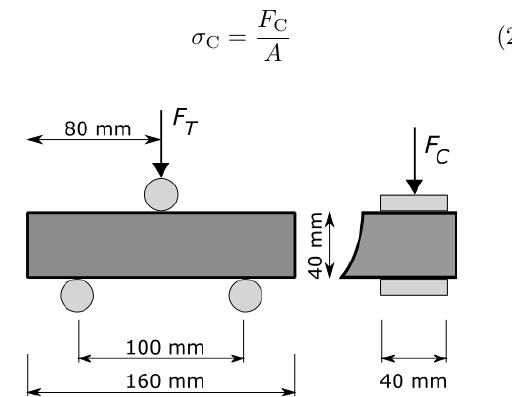
Figure 1. Macroscopic tests setting – three-point bending (left), compression